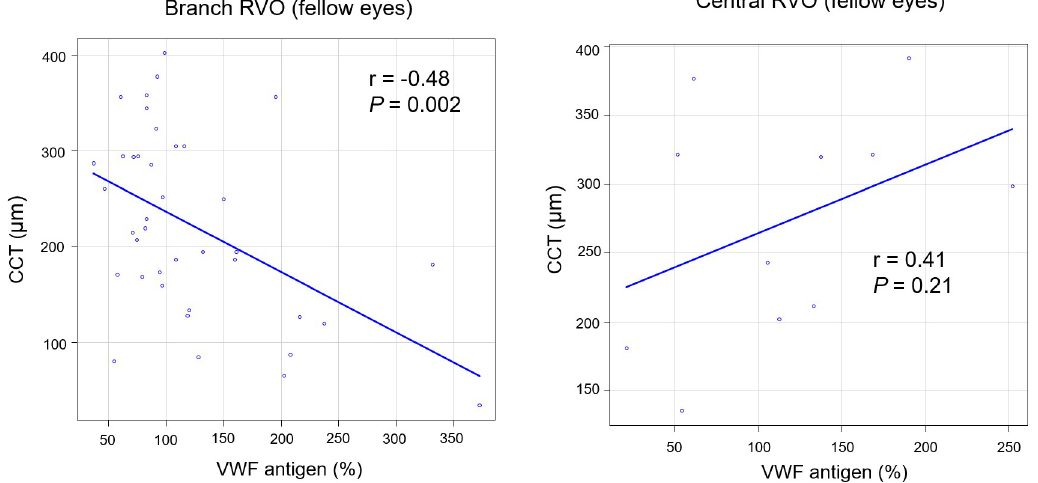
Fig 4. The correlation between VWF antigen and the CCT of fellow eyes at 1 month after anti-VEGF treatment. CCT, central choroidal thickness; RVO, retinal vein